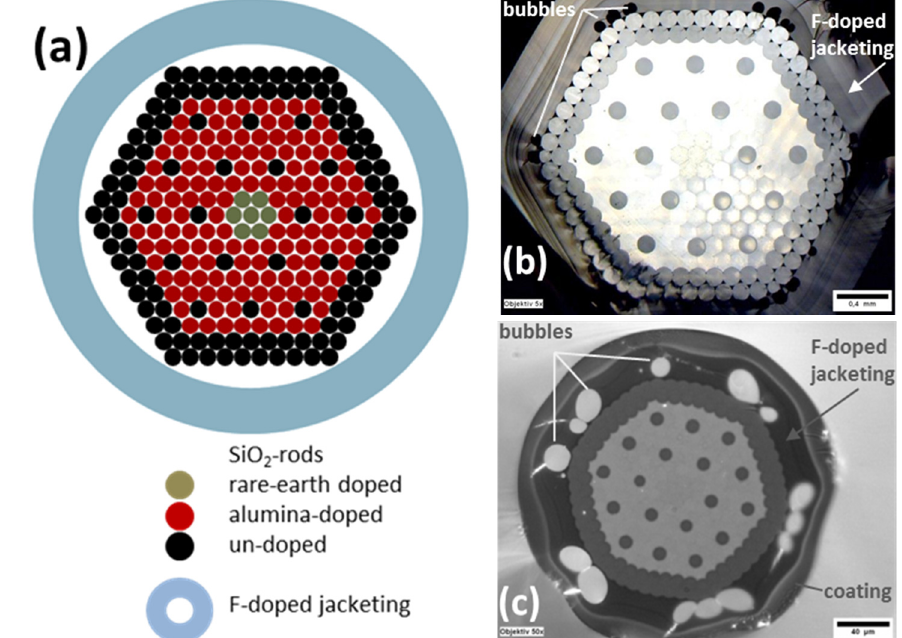
Figure 7. ( a ) Stacking plan of doped and undoped rods in a fluorinated tube: the white spots represent voids; ( b ) cross-sectional image of the drawn cane of a diameter of 3 mm; and ( c ) cross-sectional image of the drawn fiber of a diameter of 250 µm. Both ( b ) cane and ( c ) fiber were drawn from the same preform ( a ) prepared by overcladding the package with a high fluorine doped